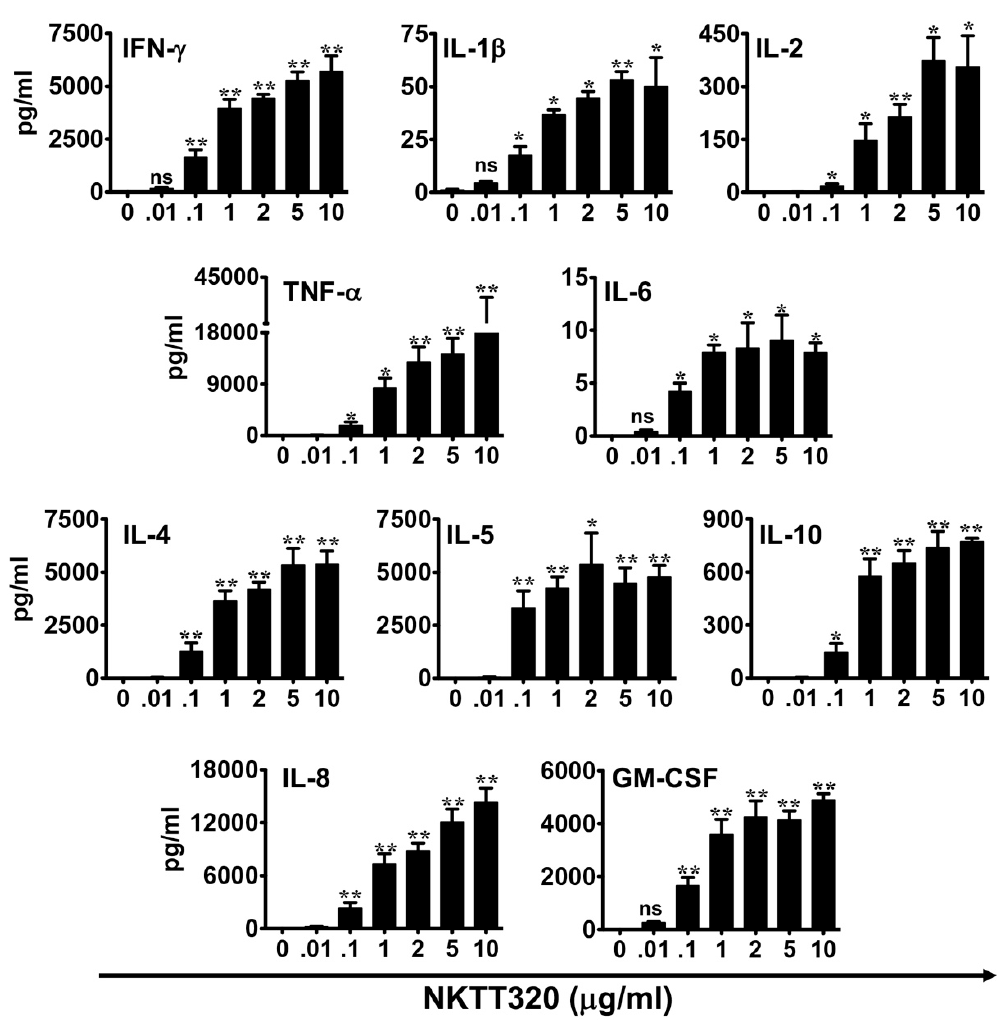
Figure 3. NKTT320 promotes Th1/Th2 cytokine production by human iNKTs. Human iNKTs were incubated with increasing concentrations of plate-bound NKTT320 mAb. After 24 h, cell culture supernatants were harvested and analyzed for Th-1 and Th-2 cytokines by Luminex. Data is